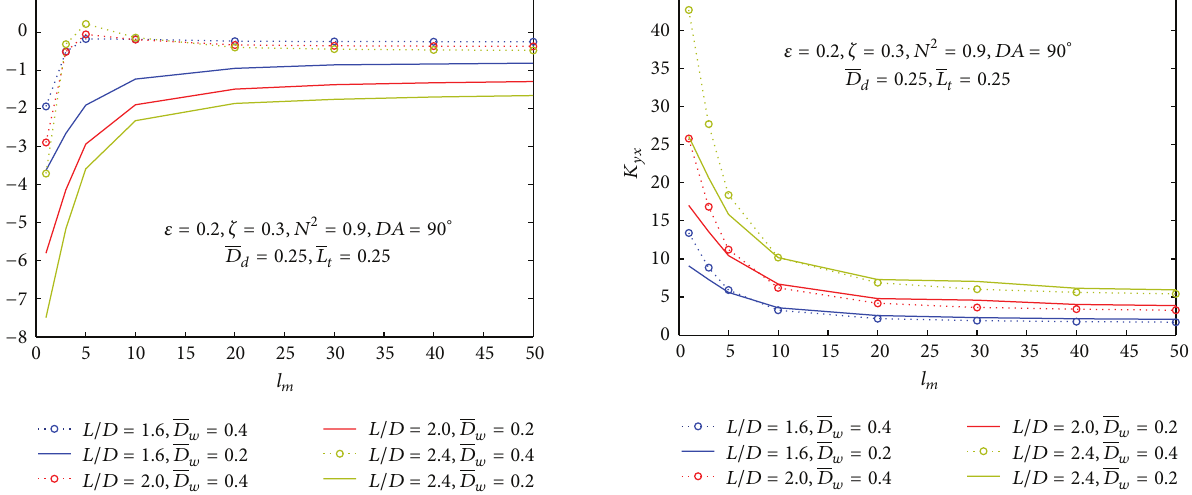
Figure 7: Variation of K 𝑦𝑥 as a function of characteristics length .” “ l m